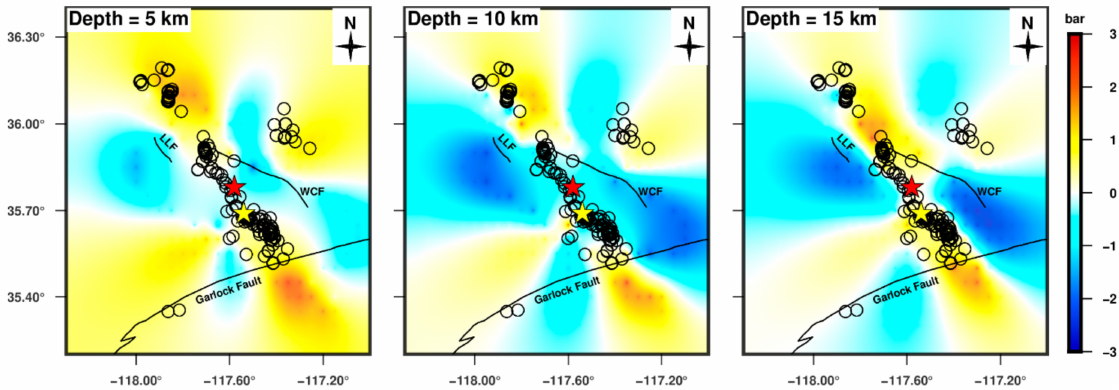
Figure 10. CFS changes on optimally oriented strike-slip faults at depths of 5, 10, and 15 km. Red and yellow stars are mainshock and foreshock, respectively. Black circles represent aftershocks (Mw > 3) for 402 d after